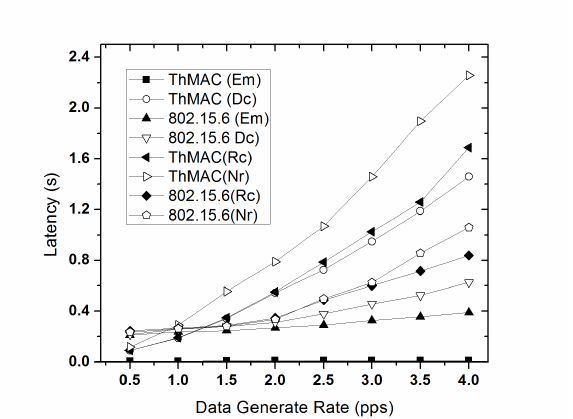
Figure 15. Average latency varying data generation